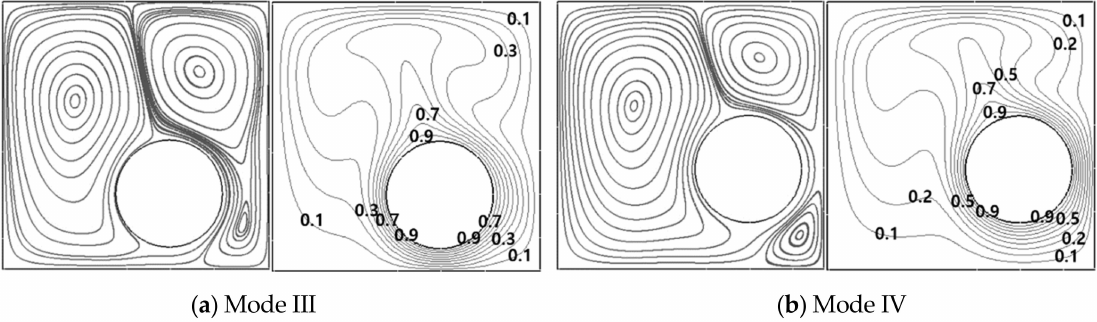
Figure 19. Streamlines (left column) and isotherms (right column) at ( a ) θ = − 60 ◦ and ( b ) θ = − 30 ◦ at a fixed r = 0.25 L for Ra = 10 5